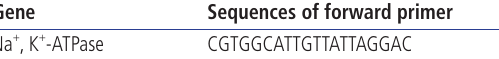
Table 2. Primer sequences of gene for Na + , K + -ATPase Gene Sequences of forward